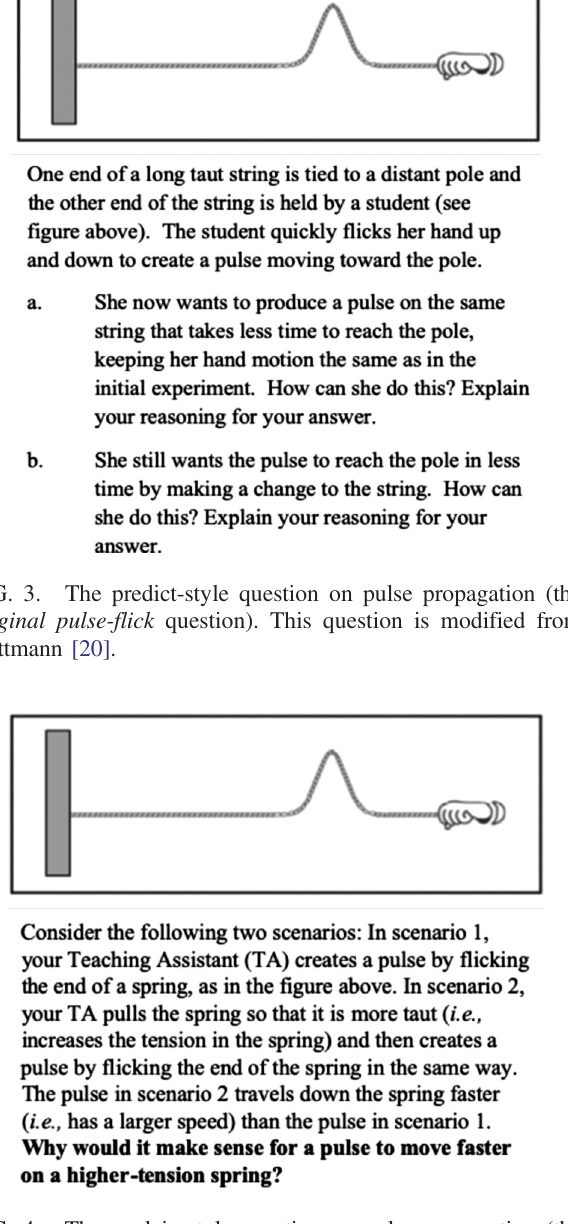
FIG. 4. The explain-style question on pulse propagation (the tension pulse-flick